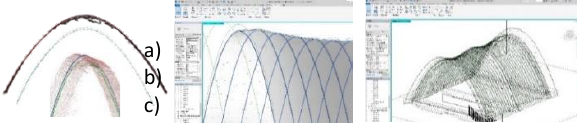
Figure 14. Left : a) Thin section of the point cloud model of the roof membrane (CIMS, 2018), b) Model lines outlining the roof membrane and the concrete shell (BIM, 2017)(Learn, 2016), c) Thin section of the roof membrane with model lines (CIMS, 2018). Center : Roof membrane and the concrete shell model lines. Right : Green: The roof membrane model lines. Blue: The concrete shell model lines. (Drawn by Rajabzadeh, 2019)